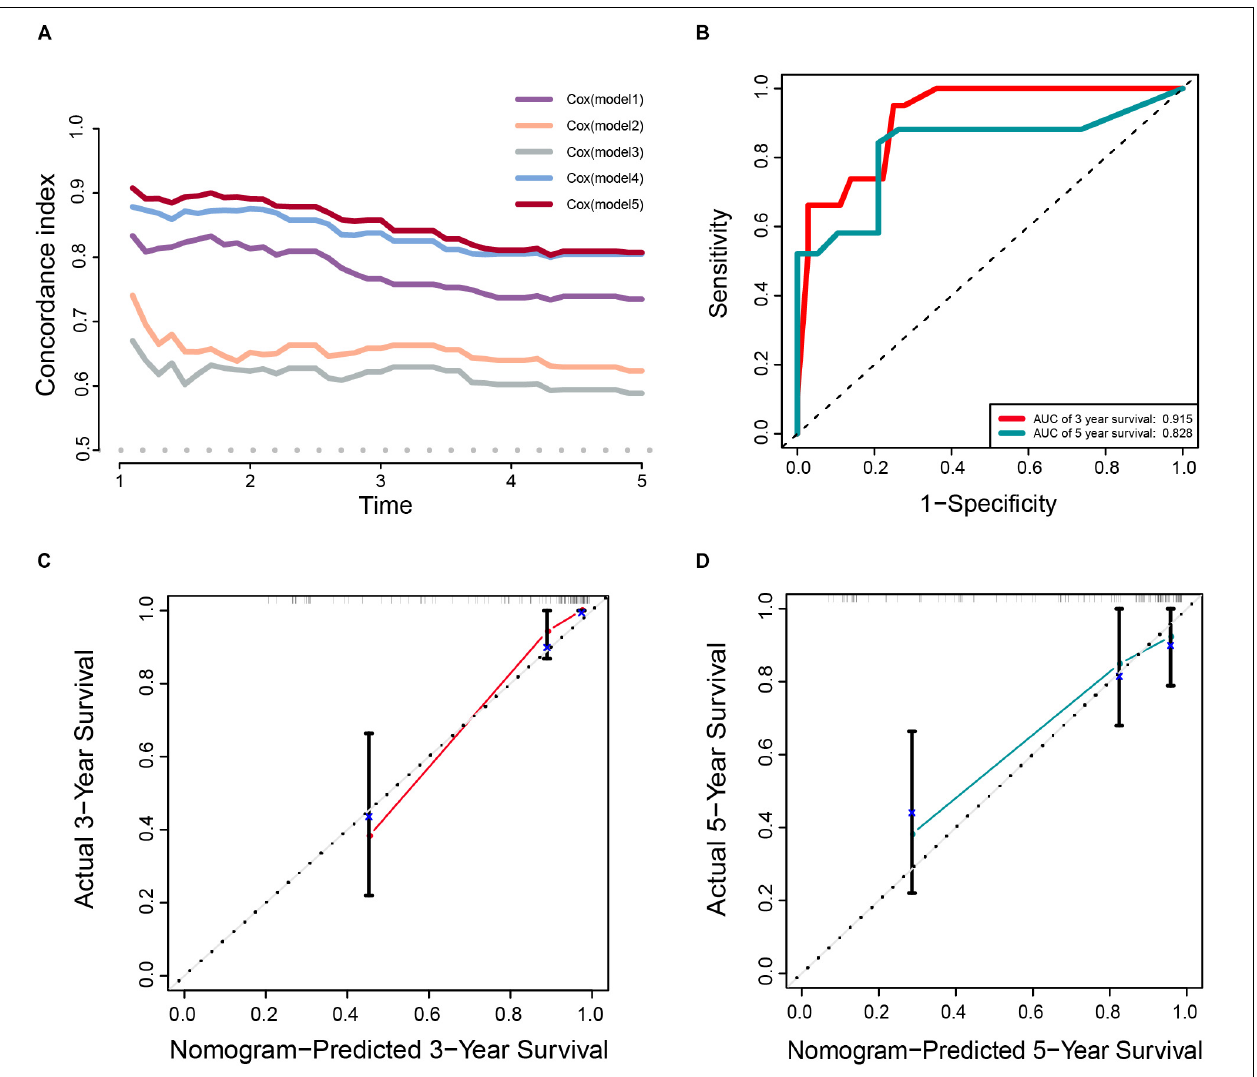
FIGURE 7 | (A) The calculation of the C-indexes in five models. (B–D) Internal validation of a prognostic stemness index-related gene signature for primary LGG. (B) Time-dependent ROC curve of the seven-gene-based risk score for 3- and 5-year OS probability in the internal validation cohort. Calibration plot for internal validation of 3- (C) and 5-year (D) OS of primary LGG patients.